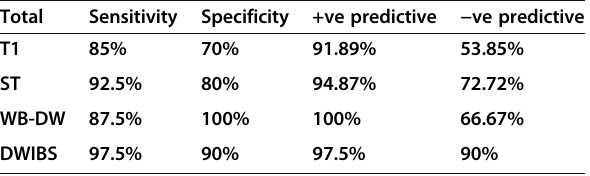
Table 5 Sensitivity, specificity, positive predictive value, and negative predictive value for total cases in all sequences